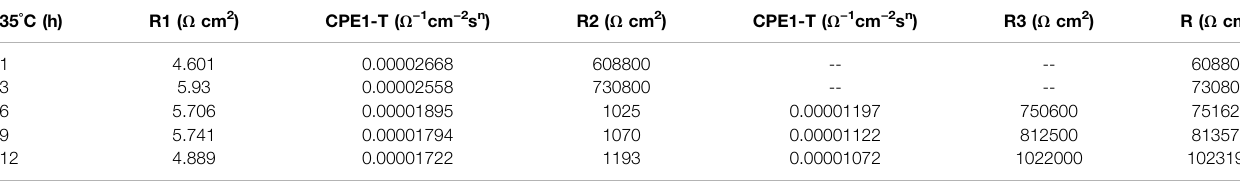
TABLE 7 | Impedance fi tting data of the heat affected zone soaked in arti fi cial seawater at 35 ° C for 12 h 35 ° C (h)